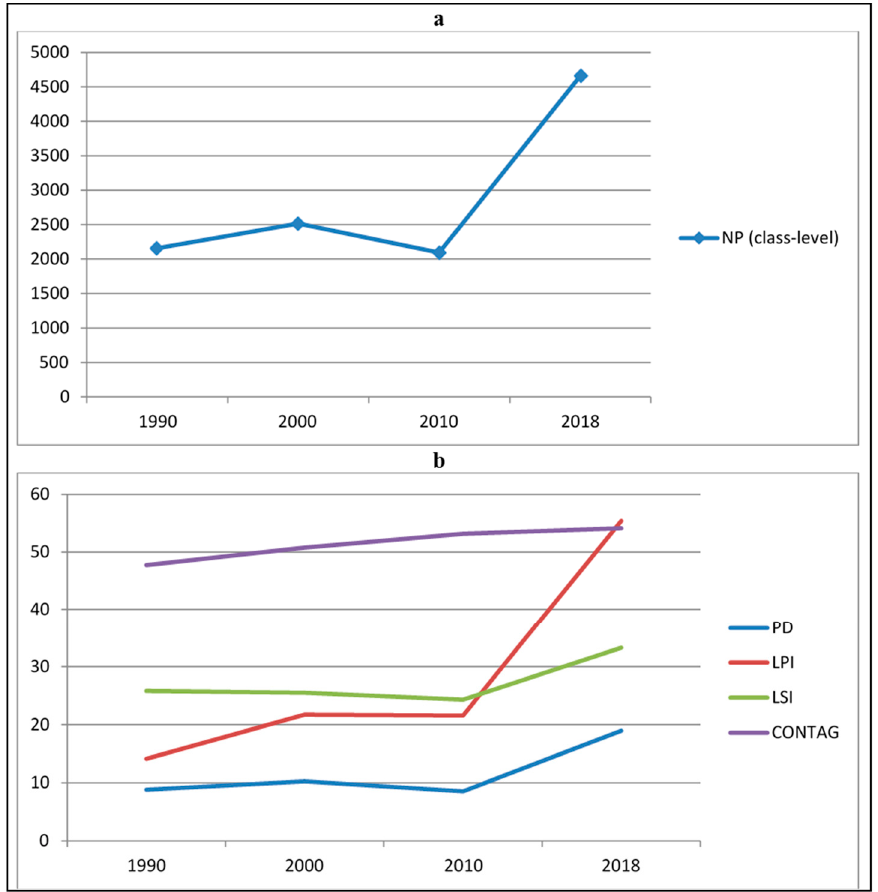
Figure 6. Curves trends of indexes at landscape